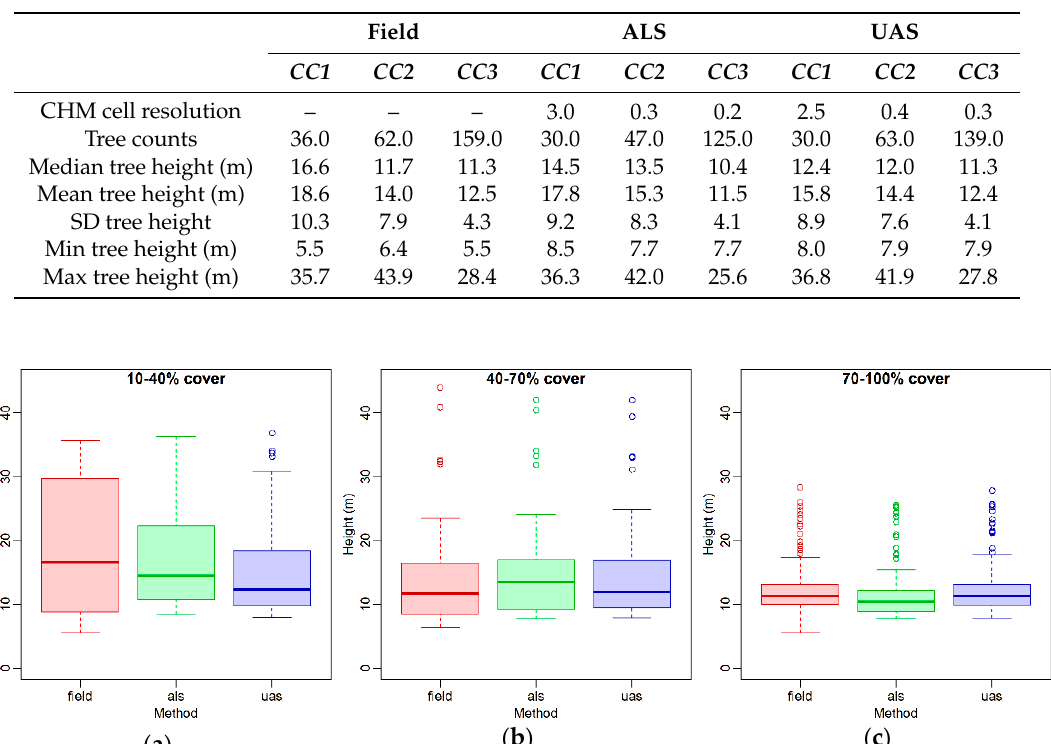
Table 3. Plot composite summaries by canopy cover class (CC) and inventory method. CC1 describes plots that had 10–40% canopy cover; CC2 40–70% canopy cover; and CC3 70–100% canopy cover.